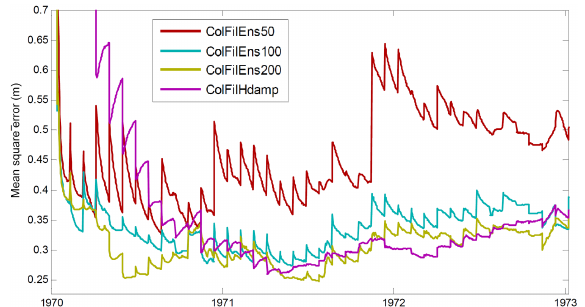
Figure 3. The temporal variation of Head RMSE in the synthetic test.